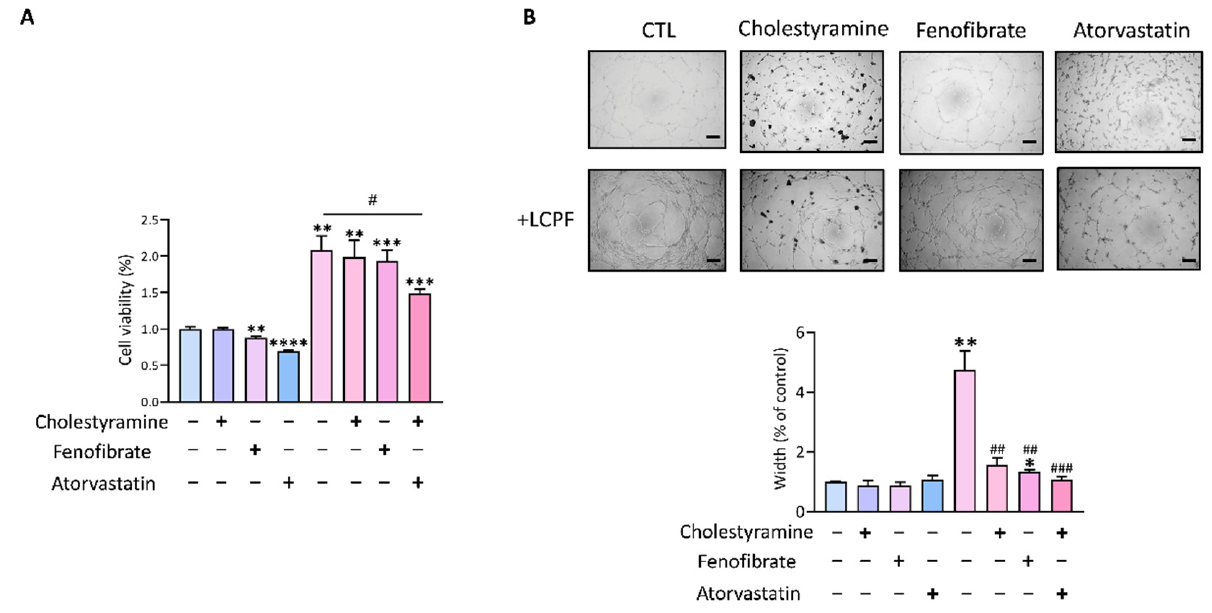
Figure 4. Effect of lipid-lowering medications on LCPF-induced endothelial viability and angio- genesis. HUVECs were treated with cholestyramine (20 µ M), fenofibrate (25 µ M), or atorvastatin (20 µ M) in a LCPF-containing medium. ( A ) Cell viability was analyzed by MTT assay after 24 h of treatment. ( B ) Representative images and analysis of tube formation after HUVECs cultured in the above conditions for 12 h are shown. Scale bar = 200 µ m. * p < 0.05; ** p < 0.01; *** p < 0.001; **** p < 0.0001, compared to the control group. # p < 0.05; ## p <0.01; ### p < 0.001, compared to the LCPF group.